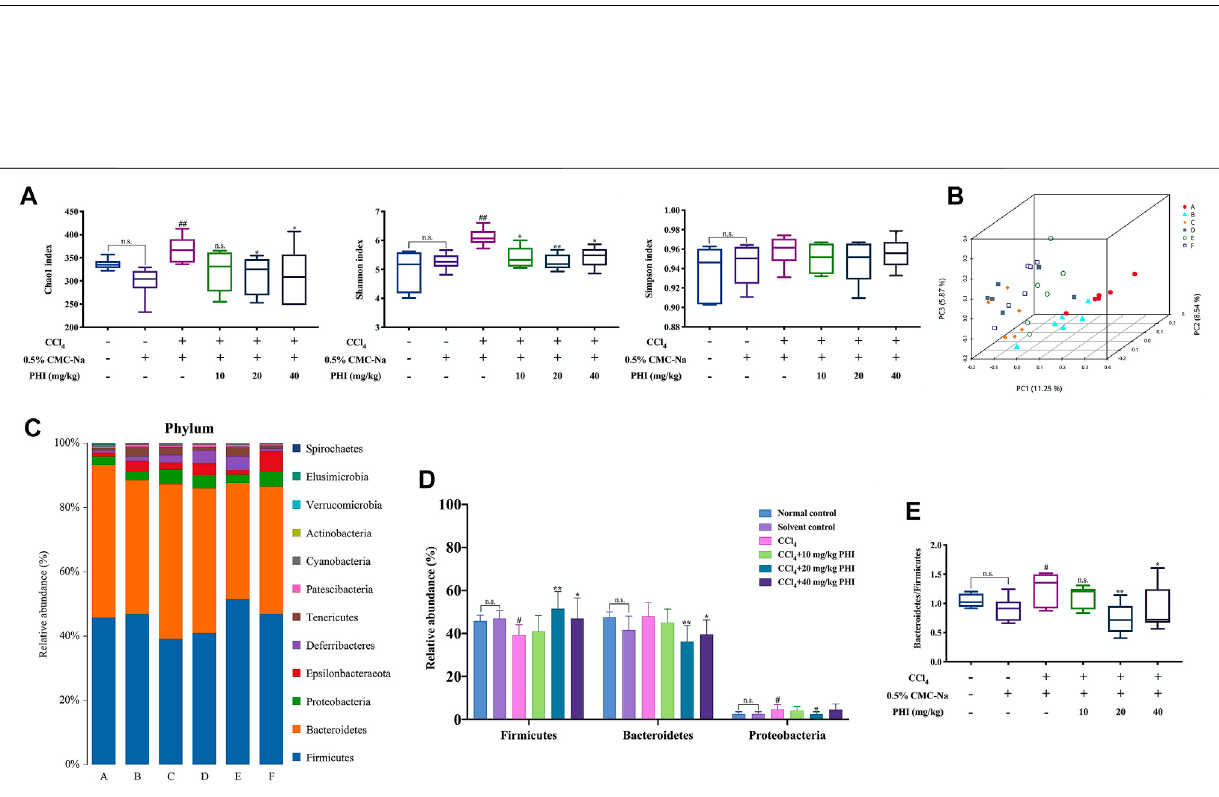
FIGURE 7 | PHI modulates the composition of gut microbiota. (A) The alpha diversity of each group was obtained using the Chao1 index, Shannon index and Simpsonindex. (B) PCoA ofgutmicrobiota. (C) Therelative abundanceofbacteriaat thephylumlevel. (D) Representativehistogram ofthegutmicrobiota atthephylum level. (E) Bacteroides toFirmicutesratio.A:Normalcontrol;B:Solventcontrol;C:CCl 4 ;D:CCl 4 +10 mg/kgPHI;E:CCl 4 +20 mg/ kgPHI;F:CCl 4 +40 mg/ kgPHI.Data wasexpressedasthemean ± SD( n (cid:1) 6). # p < 0.05, ## p < 0.01representcomparedwithsolventcontrolgroup.* p < 0.05,** p < 0.01representcomparedwithCCl 4 group. n. s indicates no signi fi